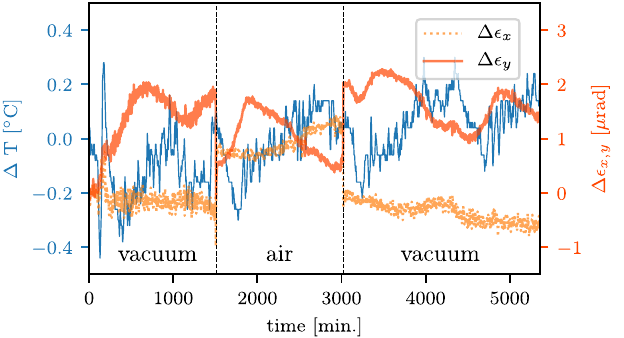
FIG. 10. MPS parallelism stability under vacuum while the air temperature is monitored for about 3.5 days. This measurement is performed after glue reticulation for 24 hours under vacuum followed by a reticulation time of 24 hours at air and then vacuum again.